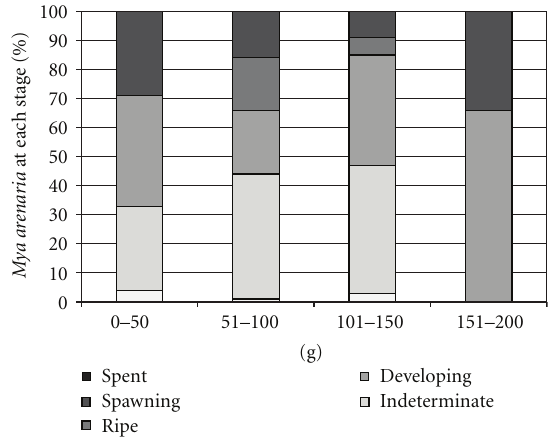
Figure 6: Relationship between female Mya arenaria weight and stage of gametogenesis.